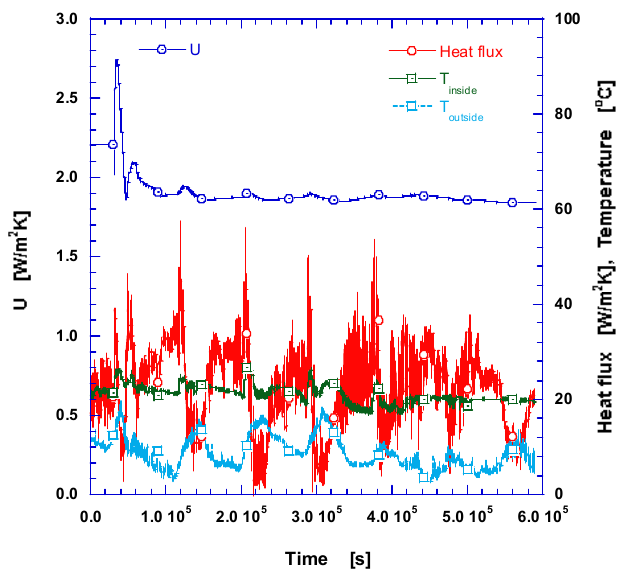
Figure 3. Thermal measurements and U-value analysis for the North window based on ISO 9869-1: 2014.